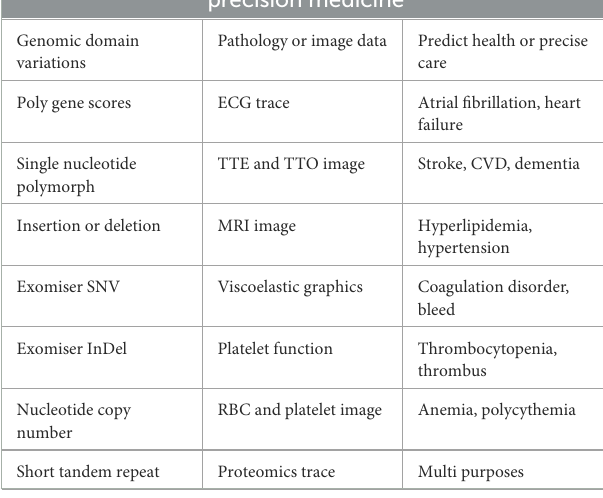
TABLE 1 Cardiocoagulum